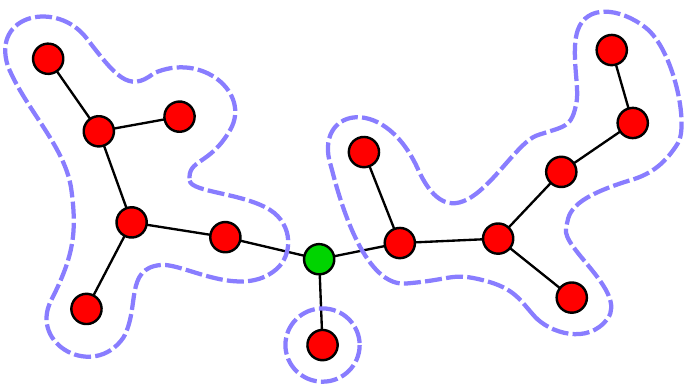
(surrounded by dashed lines), joined by one additional species (green). This is true with c probability one when there is heterogeneity in interaction